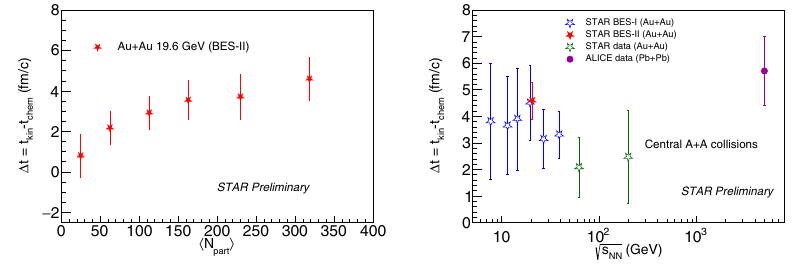
N part . Right panel: ⟨ ⟩